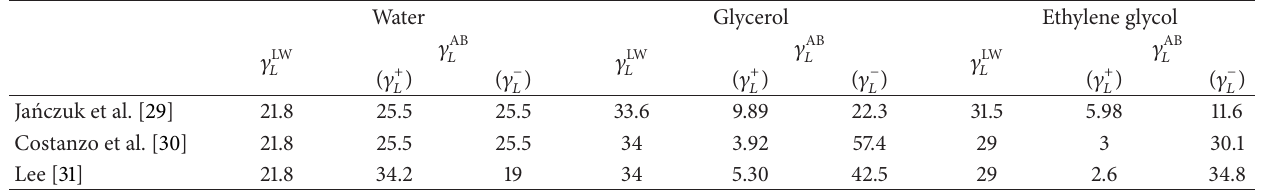
Table 2: Apolar (Lifshitz-van der Waals) and polar (Lewis acid-base: electron-acceptor and electron-donor contributions) surface tension components (mNm − 1 ) for water, ethylene glycol, and